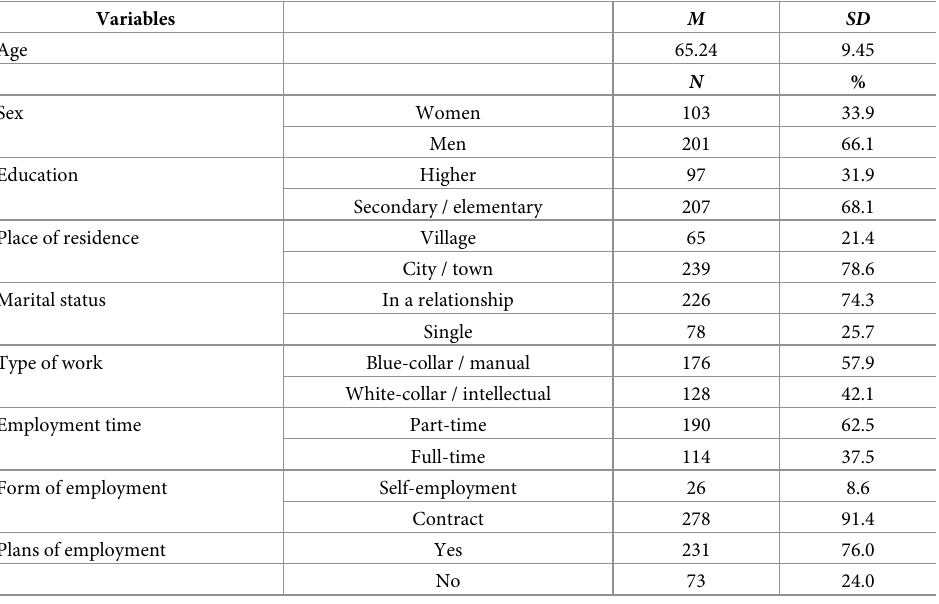
Table 1. Participants’ sociodemographic characteristics [N =